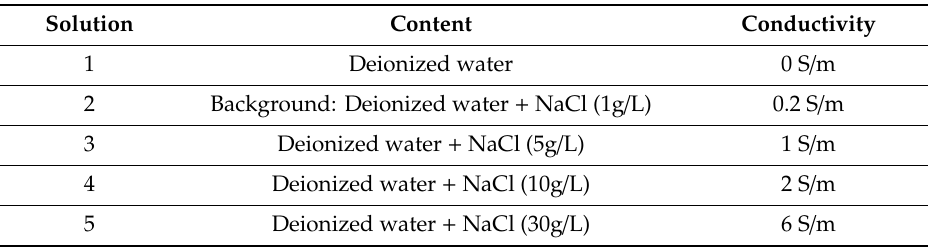
Table 2. Content and electrical conductivity of the filling